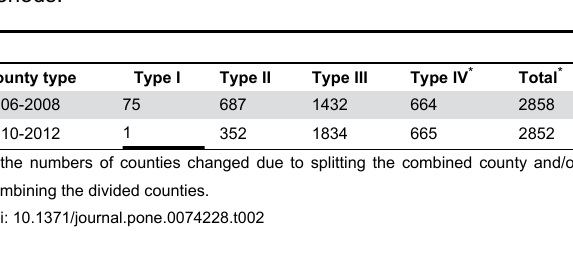
Table 2. Four types of malaria epidemic counties in two periods.